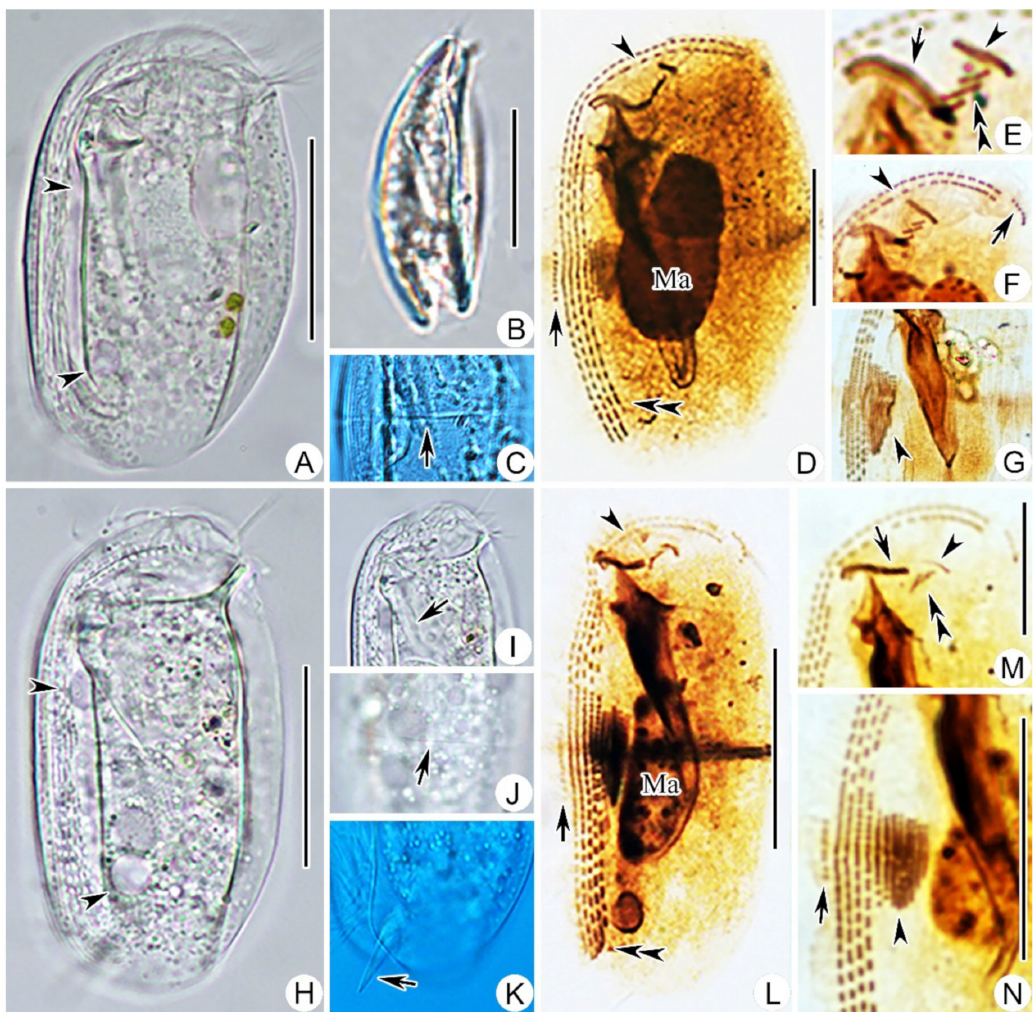
Figure 2. Photomicrographs of Dysteria paracrassipes n. sp. ( A – G ) and Dysteria crassipes ( H – N ) from life ( A – C , H – K ) and after protargol staining ( D – G , L – N ). ( A ) Left lateral view of a representative individual; arrowheads point to contractile vacuoles. ( B ) Ventral view. ( C ) To show the equatorial transverse stripe (arrowhead). ( D ) Left lateral view of the holotype specimen; arrow shows equatorial fragment; arrowheads mark frontoventral kineties and double arrowhead points to right kineties. ( E ) Oral ciliary pattern; arrow shows circumoral kineties; arrowheads mark double-rowed preoral kinety and double arrowhead points to left front kineties. ( F ) Anterior end of cell; arrow shows equatorial fragment; arrowheads mark frontoventral kineties. ( G ) Ciliary pattern of midbody; arrowhead marks right kineties. ( H ) Left lateral view of a representative individual; arrowheads point to contractile vacuoles. ( I ) Focusing on surface of left side; arrow shows one of the cytopharyngeal rods. ( J ) To show the equatorial transverse stripe (arrowhead). ( K ) Posterior portion of cell; arrow shows podite. ( L ) General view of infraciliature; arrow shows equatorial fragment; arrowhead marks frontoventral kineties and double arrowhead points to right kineties. ( M ) Oral ciliary pattern; arrow shows circumoral kineties; arrowhead marks single-rowed preoral kinety and double arrowhead points to left front kineties. ( N ) Ciliary pattern of midbody; arrowhead marks right kineties; arrow shows equatorial fragment. Ma, macronucleus. Scale bar = 25 µ